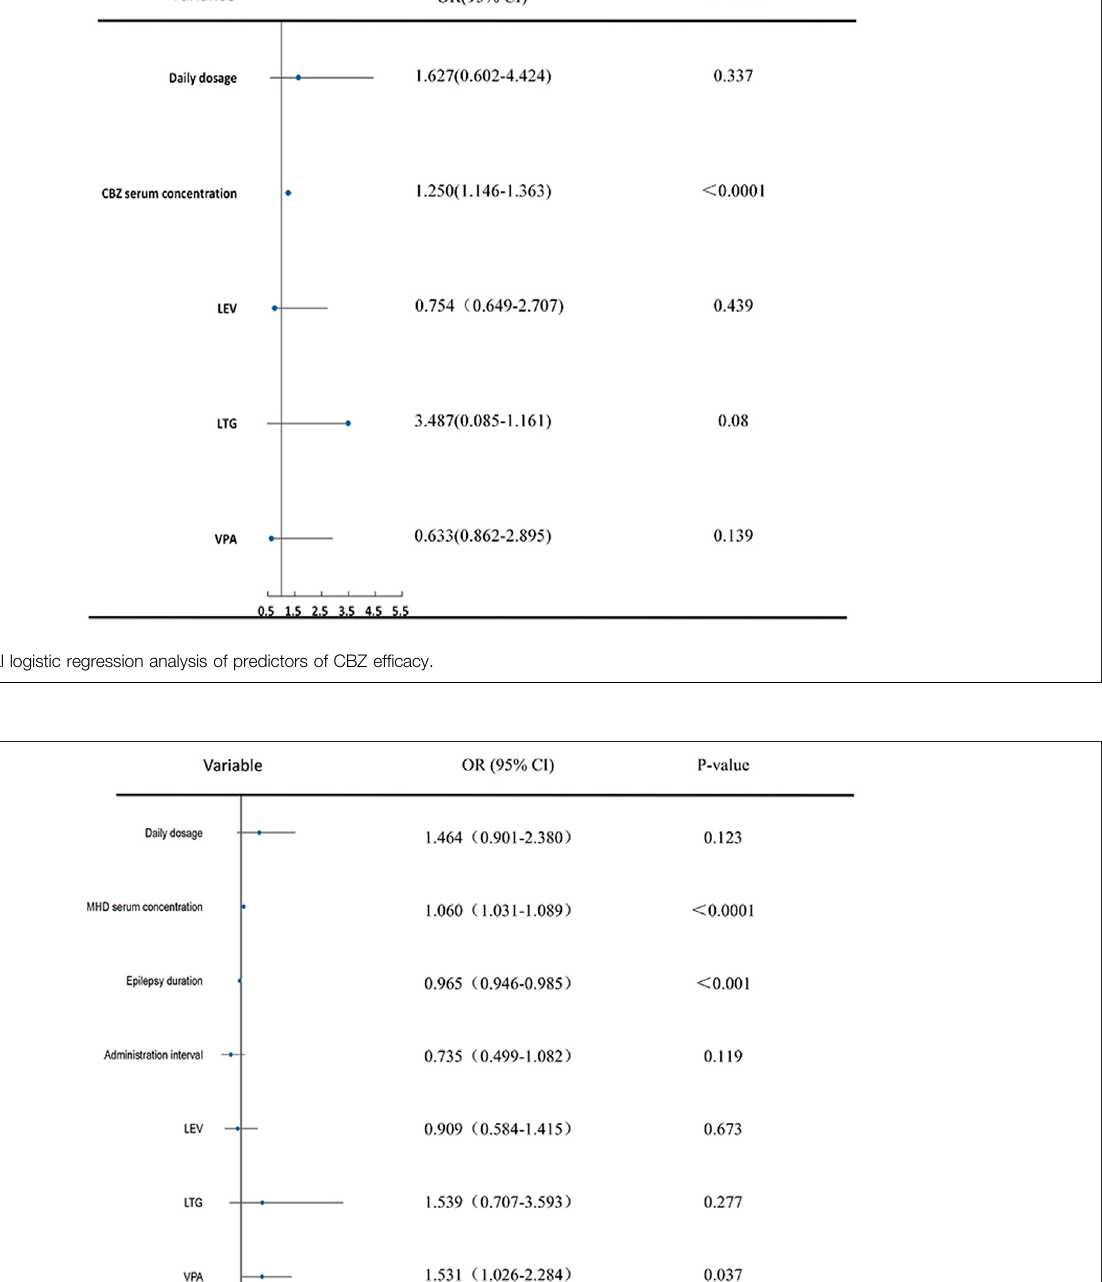
Frontiers in Pharmacology |